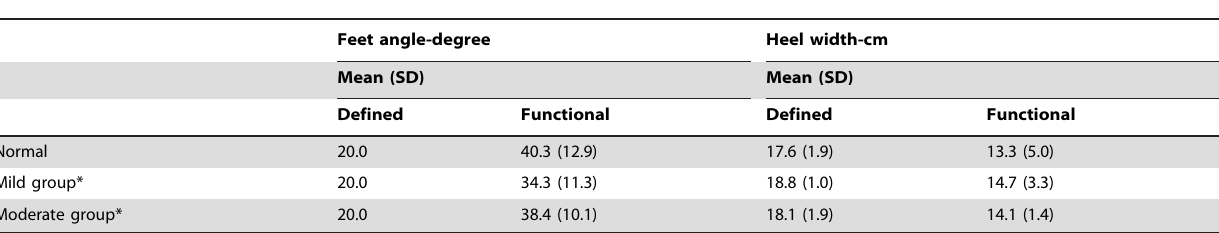
Table 2. Feet angle and heel